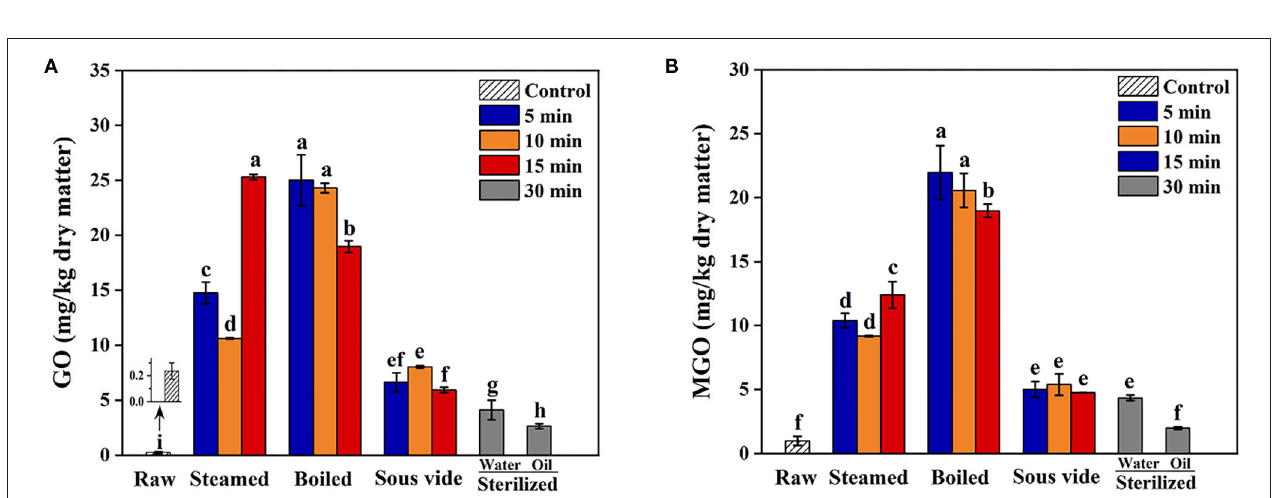
samples were below 2.5 mg MDA/kg dry sample. The values of